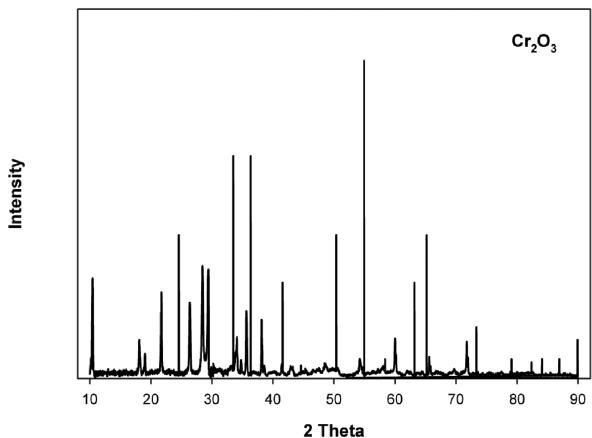
Fig. 13: X-ray diffraction pattern of chromium